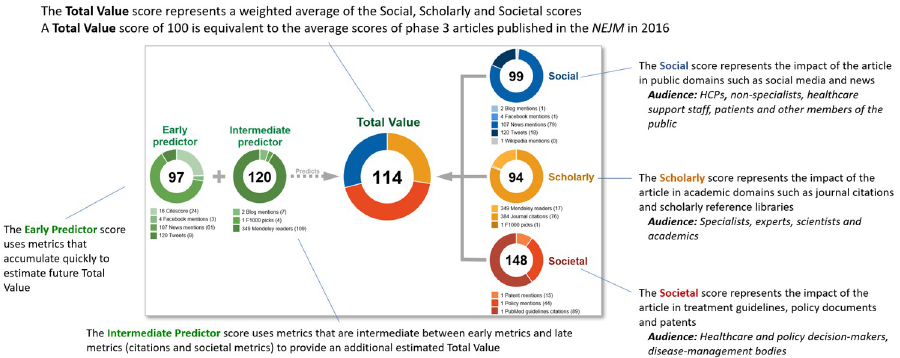
Fig 2. Example of the EMPIRE Index score for a single publication. HCP, healthcare provider; NEJM, New England Journal of Medicine